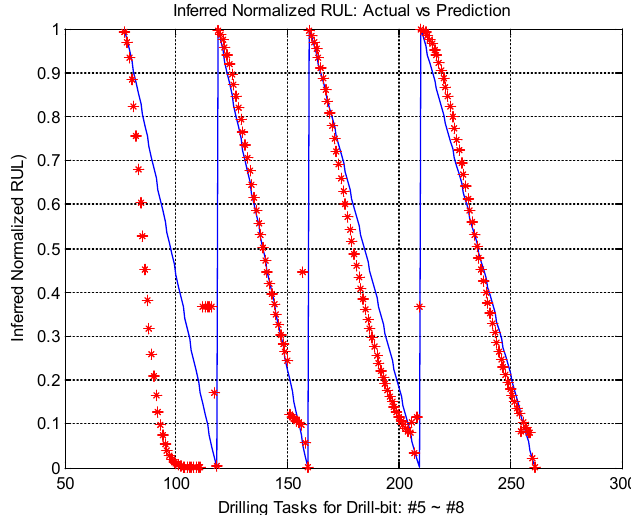
Figure 8. Normalized inferred RUL (blue line) vs. predicted RUL (red dotted line) for drill-bits #1~#4 in a delayed online setup.